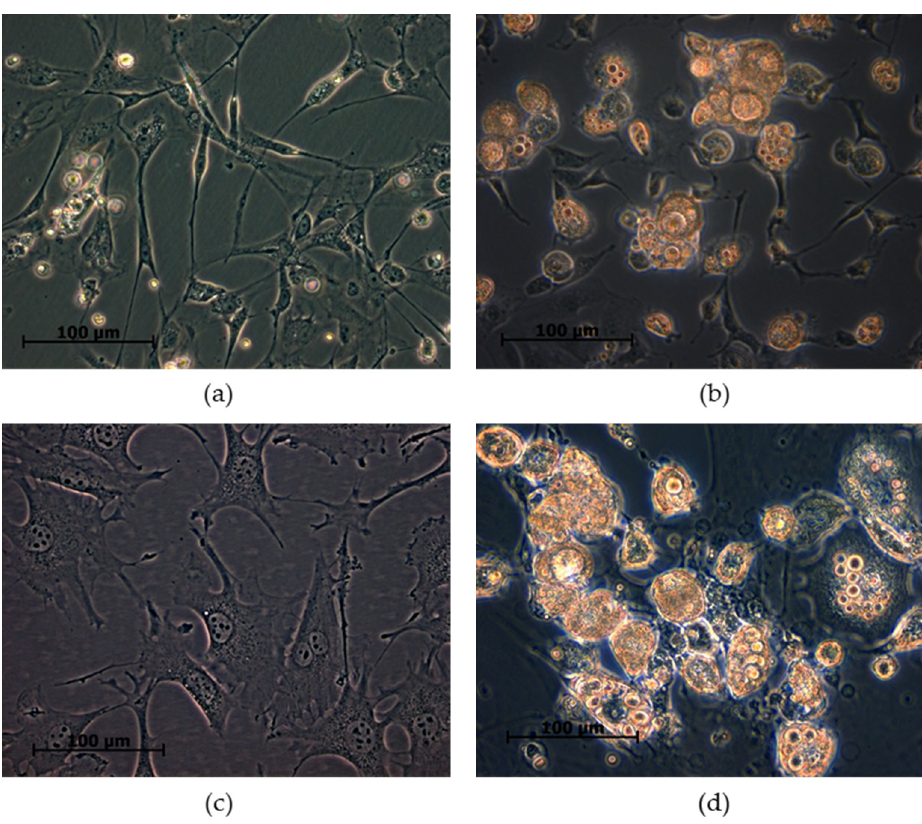
Figure 1. Images of rat adipocytes and 3T3-L1 cells. Undifferentiated rat preadipocytes ( a ) and adipocytes differentiated for 7 days ( b ). Undifferentiated 3T3-L1 ( c ) and 3T3-L1 cells differentiated for 7 days ( d